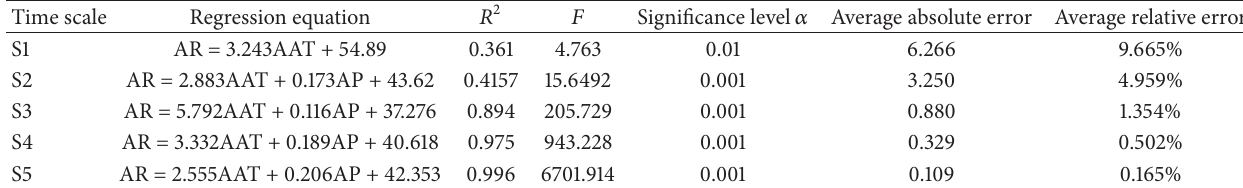
Table 2: MLREs for climatic-hydrological process at different time scales.